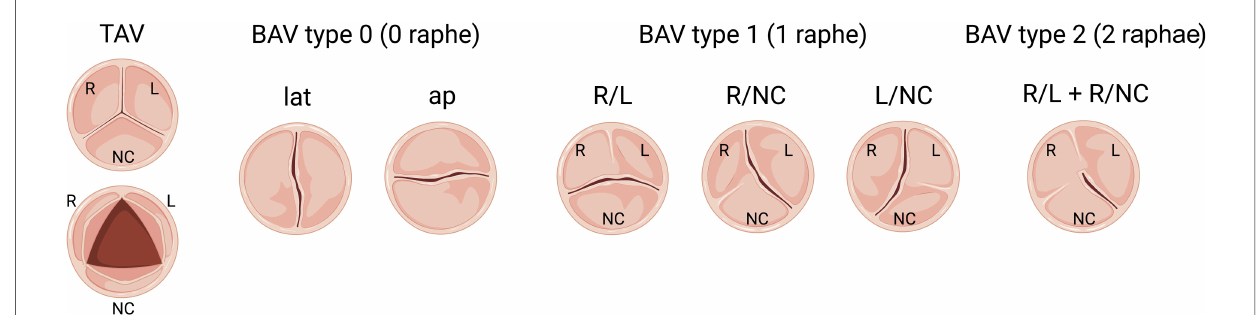
FIGURE 2 Schematic of morphologic phenotypes in bicuspid aortic valve (BAV). Schematic depiction of a normal tricuspid aortic valve (TAV) and three subtypes of BAV based on the raphe position relative to coronary artery origins: Type 0 (no raphe), Type 1 (one fi brous raphe) and Type 2 (two raphae). Type 1 is the most common, including BAV R/L (right-left fusion), R/NC (right-noncoronary fusion) and L/NC (left-noncoronary fusion), followed by Type 0, including lat (lateral arrangement of the free edge of the cusps) and ap (anterior-posterior arrangement of the free edge of the cusps), and the most infrequent is Type